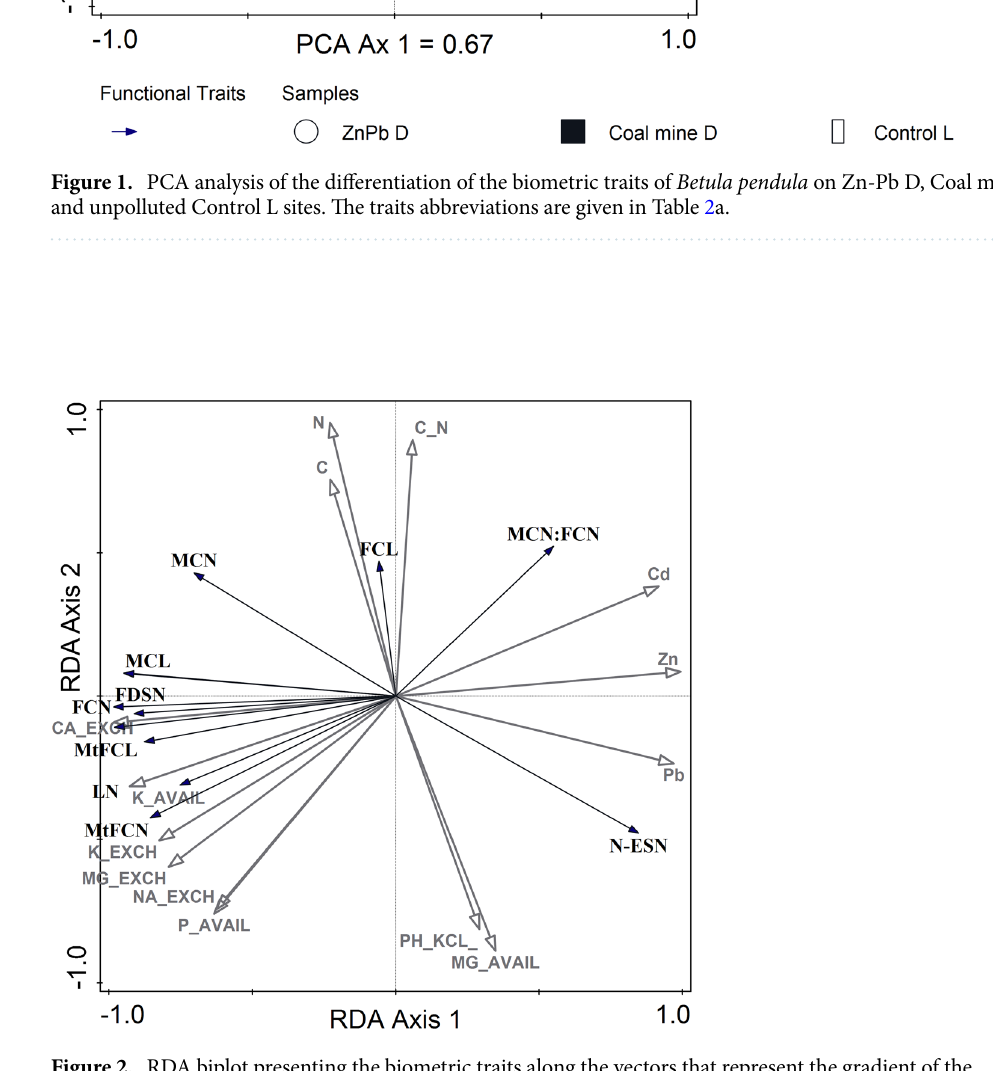
Figure 2. RDA biplot presenting the biometric traits along the vectors that represent the gradient of the environmental variables. All abbreviations are given in Table